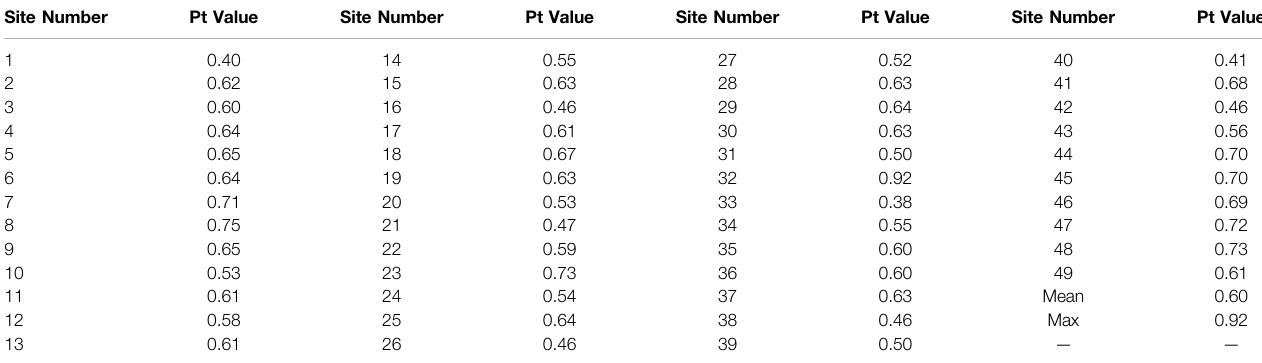
TABLE 4 | Lushan scenic area soil heavy metal Nemerow comprehensive pollution index.